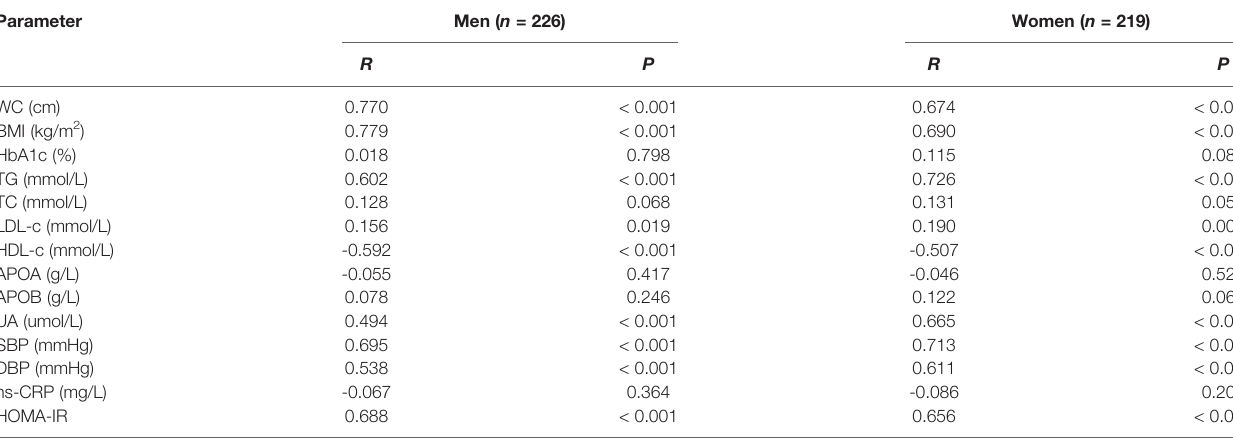
TABLE 3 | Main correlations between metabolic parameters and PrFT in newly diagnosed T2DM divided by sex. Parameter